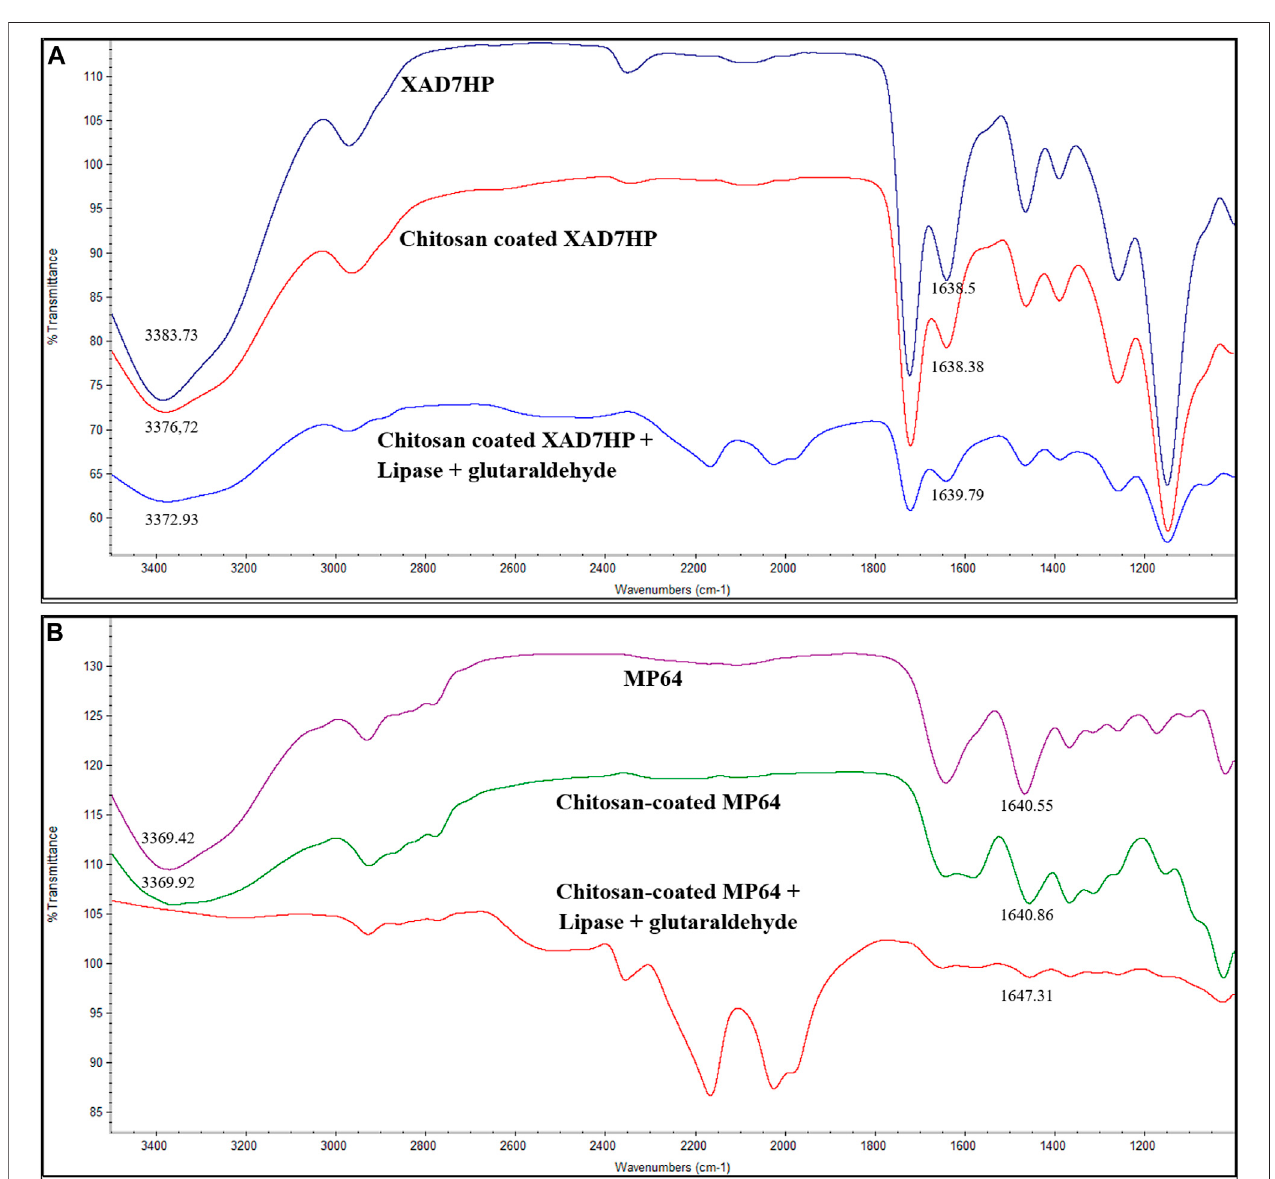
FIGURE 1 | FTIR spectrum of resins: (A) XAD-7HP and (B) MP-64.